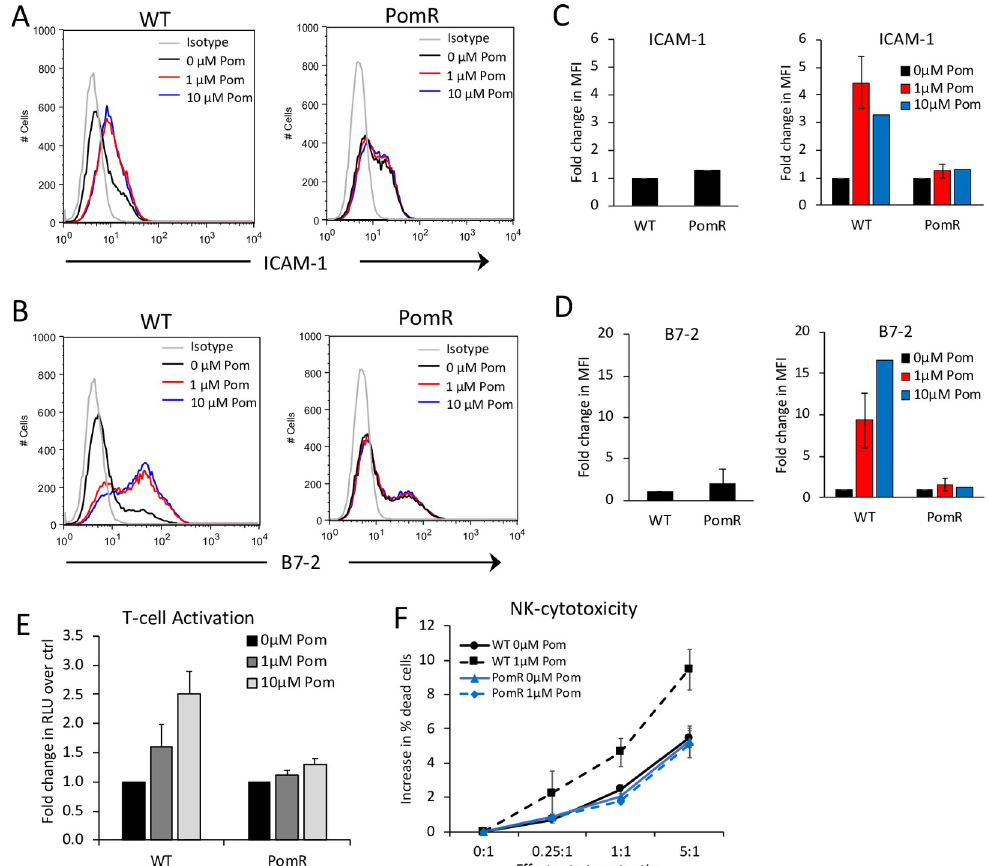
Fig 6. Pom does not increase ICAM-1 and B7-2 surface expression or T-cell and NK-cell recognition of Pom-resistant cells. WT and PomR BCBL-1 cells were cultured in the presence of DMSO ctrl (0 μ M Pom) or indicated concentrations of Pom. After 48 hours, surface expression levels of ICAM-1 and B7-2 were measured as well as Jurkat T-cell and YTS NK-cell activation by the WT and PomR cells were determined. (A and B) ICAM-1 (A) and B7-2 (B) levels determined using flow cytometry after staining with FITC-conjugated IgG isotype control, anti-ICAM-1, or anti-B7-2 antibodies. (C and D) Mean fold changes in median fluorescence intensity (MFI) of ICAM-1 (C) and B7-2 (D) from 4 and 6 independent experiments, respectively (except 10 μ M Pom-treatment, which was done once). Left panels show fold changes in ICAM-1 and B7-2 in PomR BCBL-1 cells relative to WT BCBL-1 cells. Right panels show fold changes in ICAM-1 and B7-2 in Pom-treated WT and PomR BCBL-1 cells relative to DMSO ctrl-treated cells. (E) T-cell activation of IL2-Jurkat cells by WT or PomR BCBL- 1 cells after 6 hours co-culture in the presence of 10 μ g/mL anti CD3 antibody. Activation is expressed as average fold change in luciferase activity by Pom-treated cells over DMSO ctrl-treated cells from 3 independent experiments. (F) NK- mediated cytotoxicity of WT or PomR BCBL-1 cells after 4 hours co-culture with YTS NK cell line. NK-cytotoxicity was measured by flow cytometry and expressed as average increase in % dead cells in the presence of NK cells at various effector to target ratios from 3 independent experiments. Error bars represent standard deviations. 5D). This result could be explained by the decreased expression of cereblon in PomR cells (Fig 5C). These observations indicate that, similar to multiple myeloma cells, PELs can develop